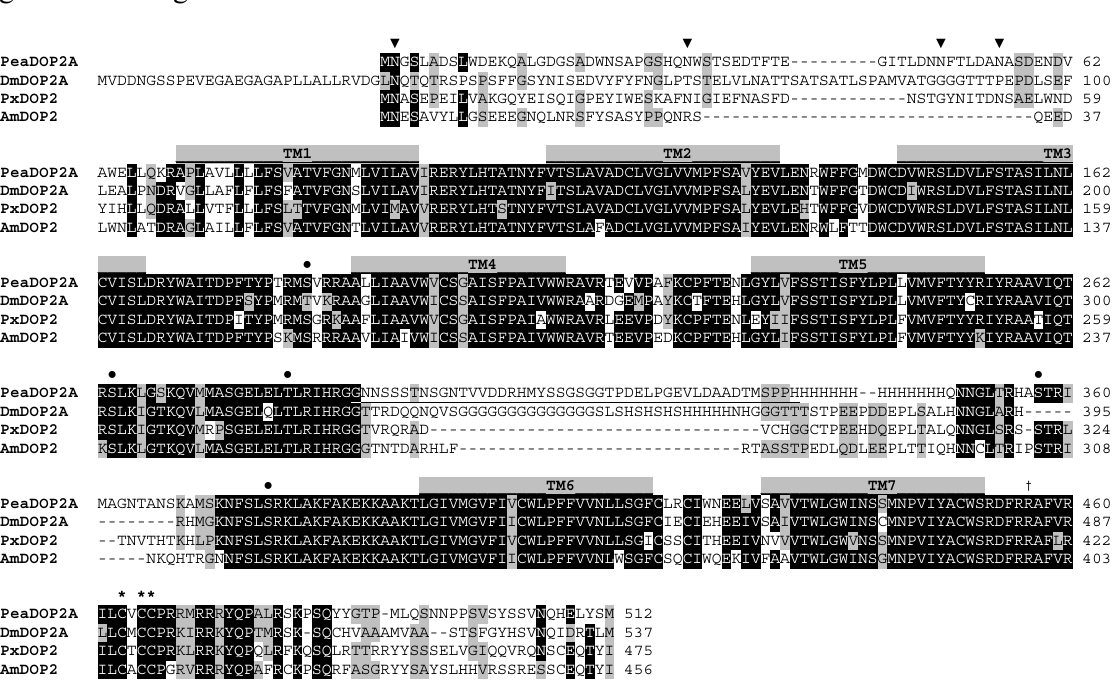
( † ) is the last 456